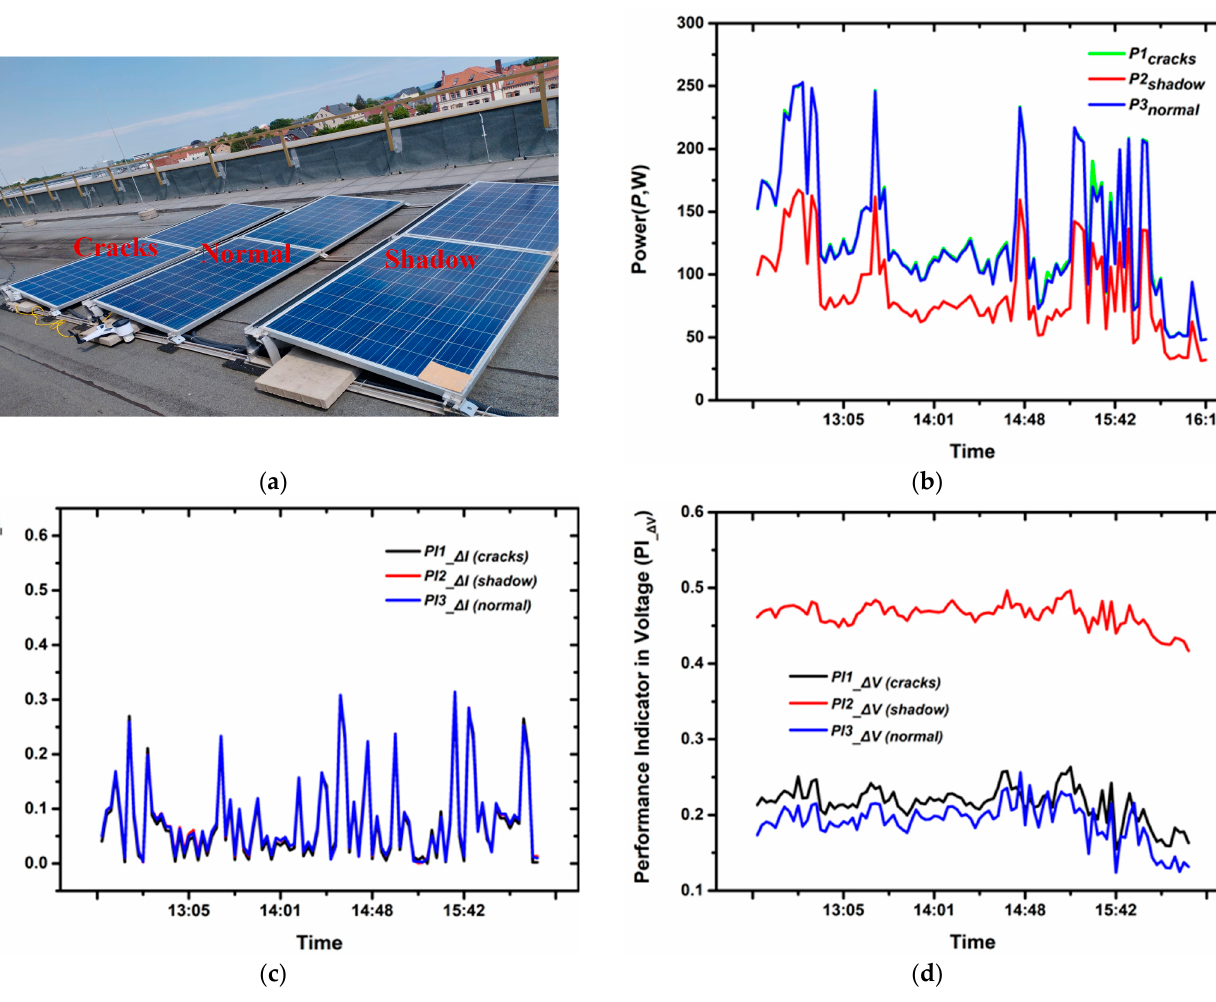
Figure 14. Performance indicators for three states of PV modules at same time: ( a ) experiment condition; ( b ) power differences for three states; ( c ) performance indicator in current; ( d ) performance indicator in voltage.